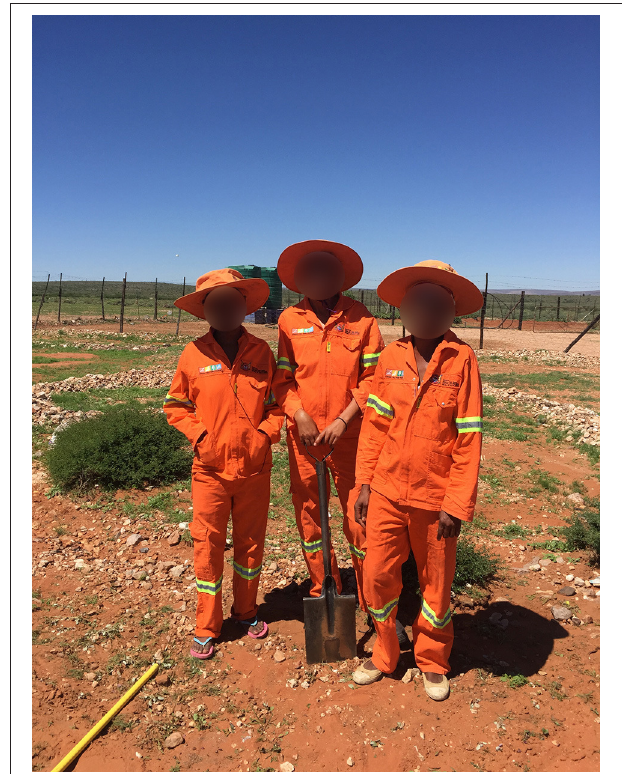
FIGURE 2 | Outdoor workers wearing broad-brimmed hats and protective clothing in Groblershoop, the Northern